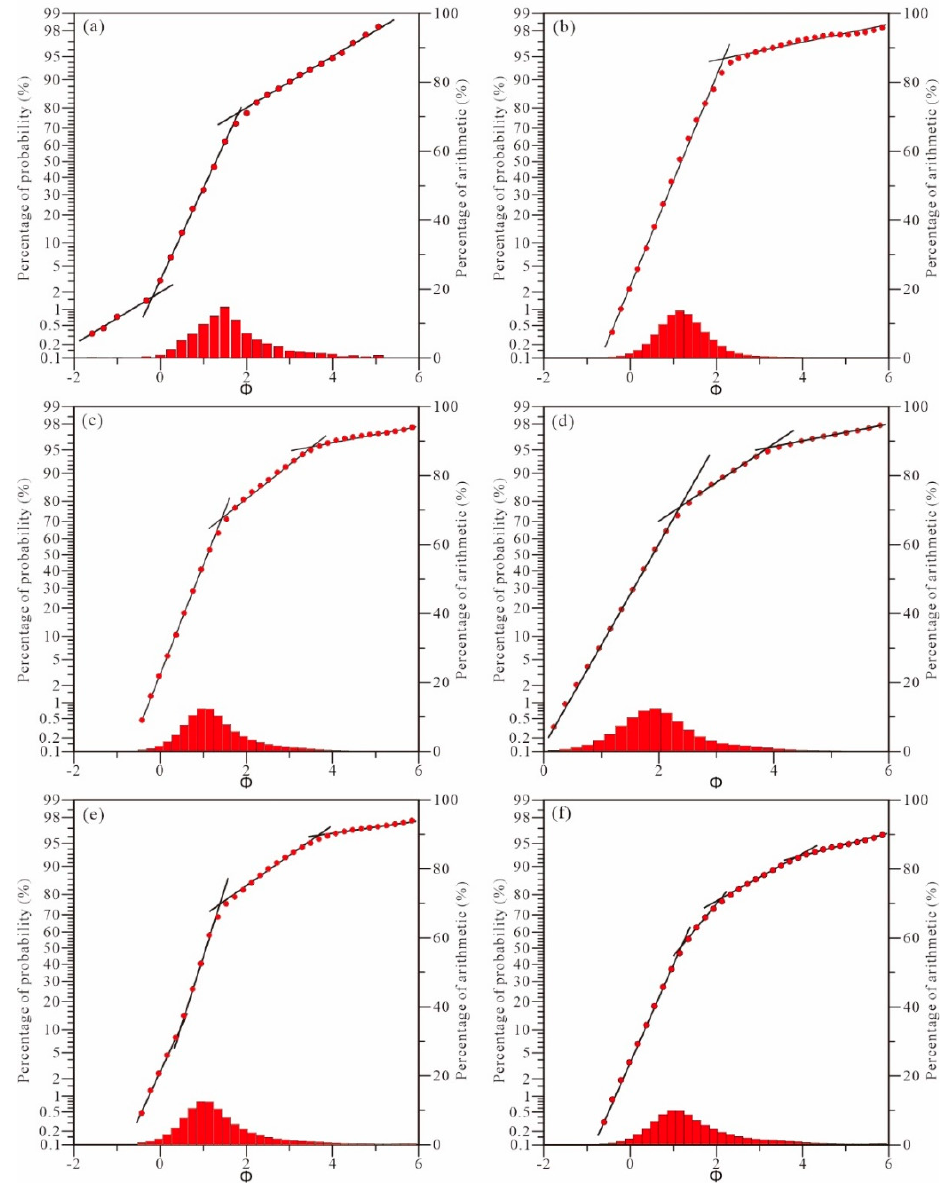
Figure 2. Grain size curves of tractive current type. ( a ) Well M16, 4041.80 m, tri − segment pattern, subaqueous distributary channel microfacies of shallow − water delta inner front; ( b ) Well QS402, 3979.33 m, bi − segment pattern, subaqueous distributary channel microfacies of shallow − water delta outer front; ( c ) Well QS201, 4018.70 m; one bouncing segment − one suspension segment − one transitional zone pattern, estuary bar microfacies of shallow − water delta outer front; ( d ) Well QS4, 4003.50 m, one bouncing segment − one suspension segment − one transitional zone pattern, subaqueous distributary channel microfacies of shallow − water delta outer front; ( e ) Well QS201, 4017.50 m, bi − bouncing segment ‐ one suspension segment − one transitional zone pattern, estuary bar microfacies of shallow − water delta outer front; ( f ) well M16, 4044.10 m, one bouncing segment − one suspension segment ‐ one complex transitional zone pattern, subaqueous distributary channel microfacies of shallow − water delta inner front.